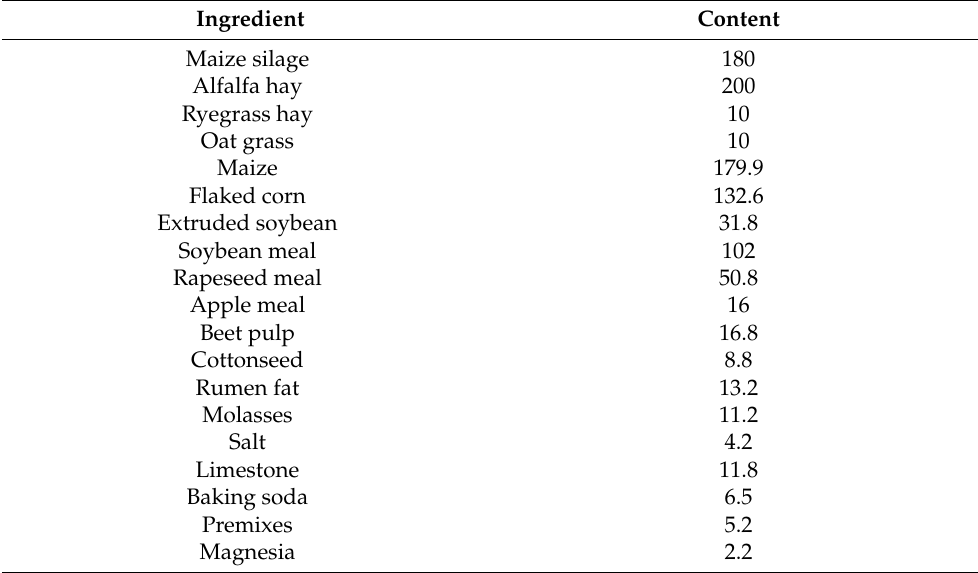
Table 1. Feed composition of Holstein cows (g/kg